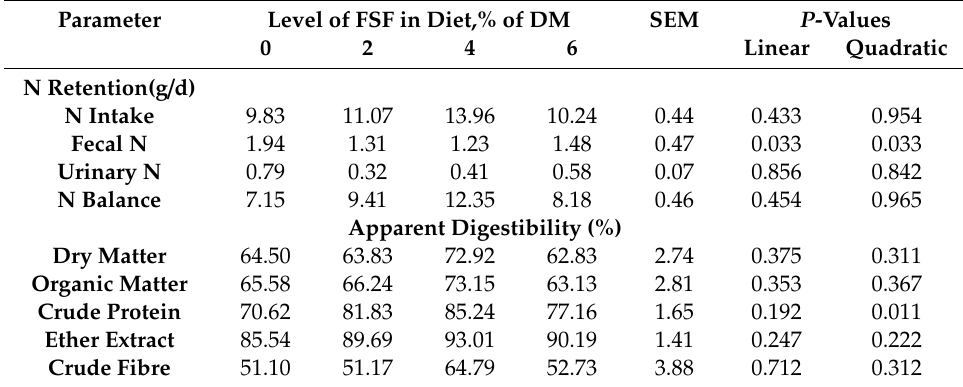
Table 3. Nitrogen utilization (g / d) and apparent digestibility (%) of Dohne Merino fed varying levels of Fossil shell